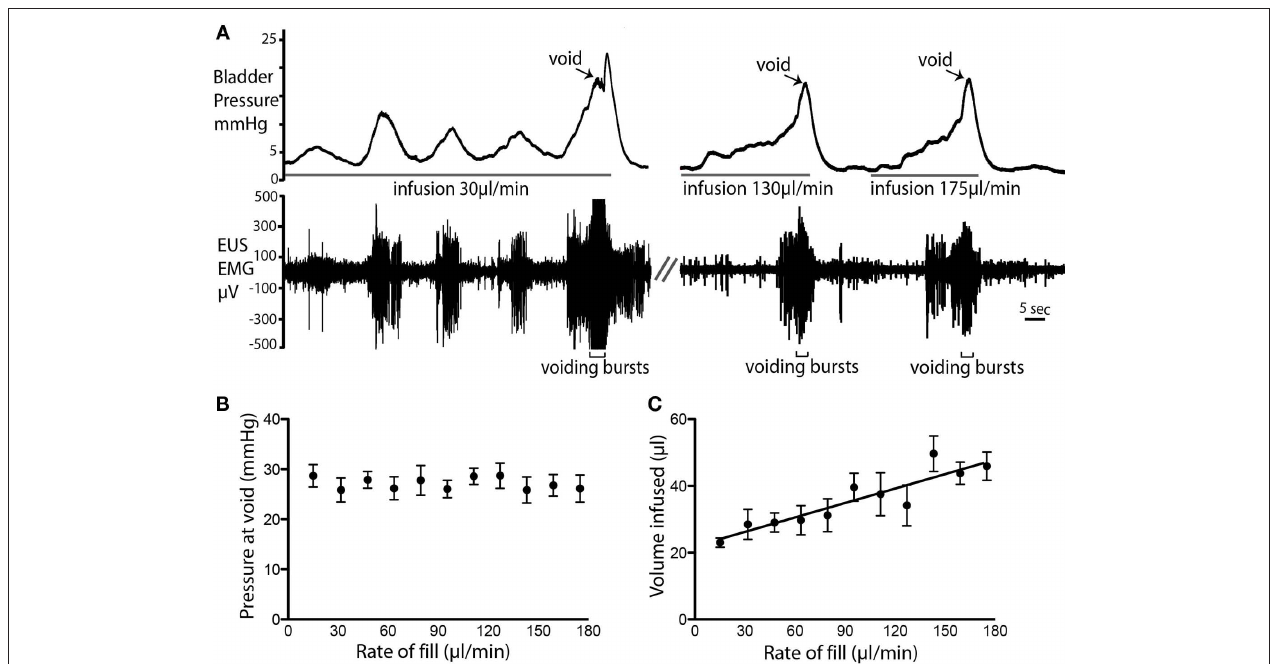
Figure 4 | rate of fluid infusion and bladder pressure at void. (A) Example voids showing that at slower infusion rates (e.g., 30 μl/min) it took longer for a void to be triggered and a larger number of NMCs were observed before the void. Note also the EMG activity that accompanied each NMC. At higher infusion rates,